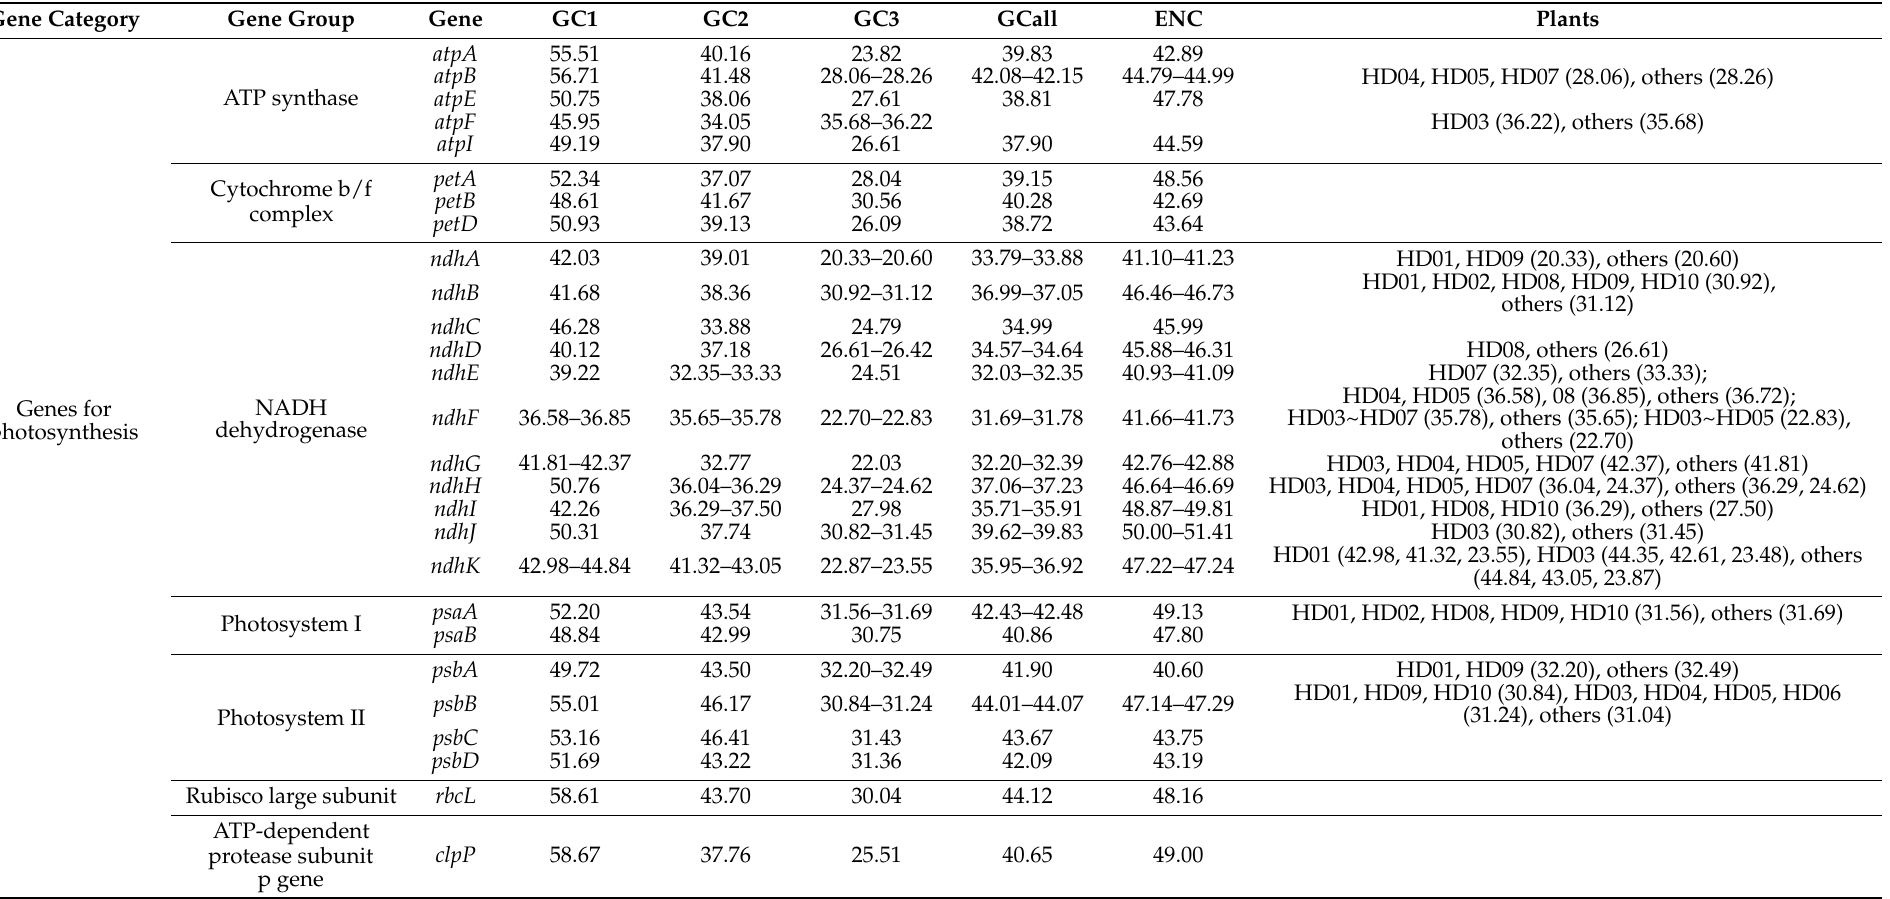
Table 2. GC content at different positions and ENC values of codons in the chloroplast genome of oil-tea camellia. Gene